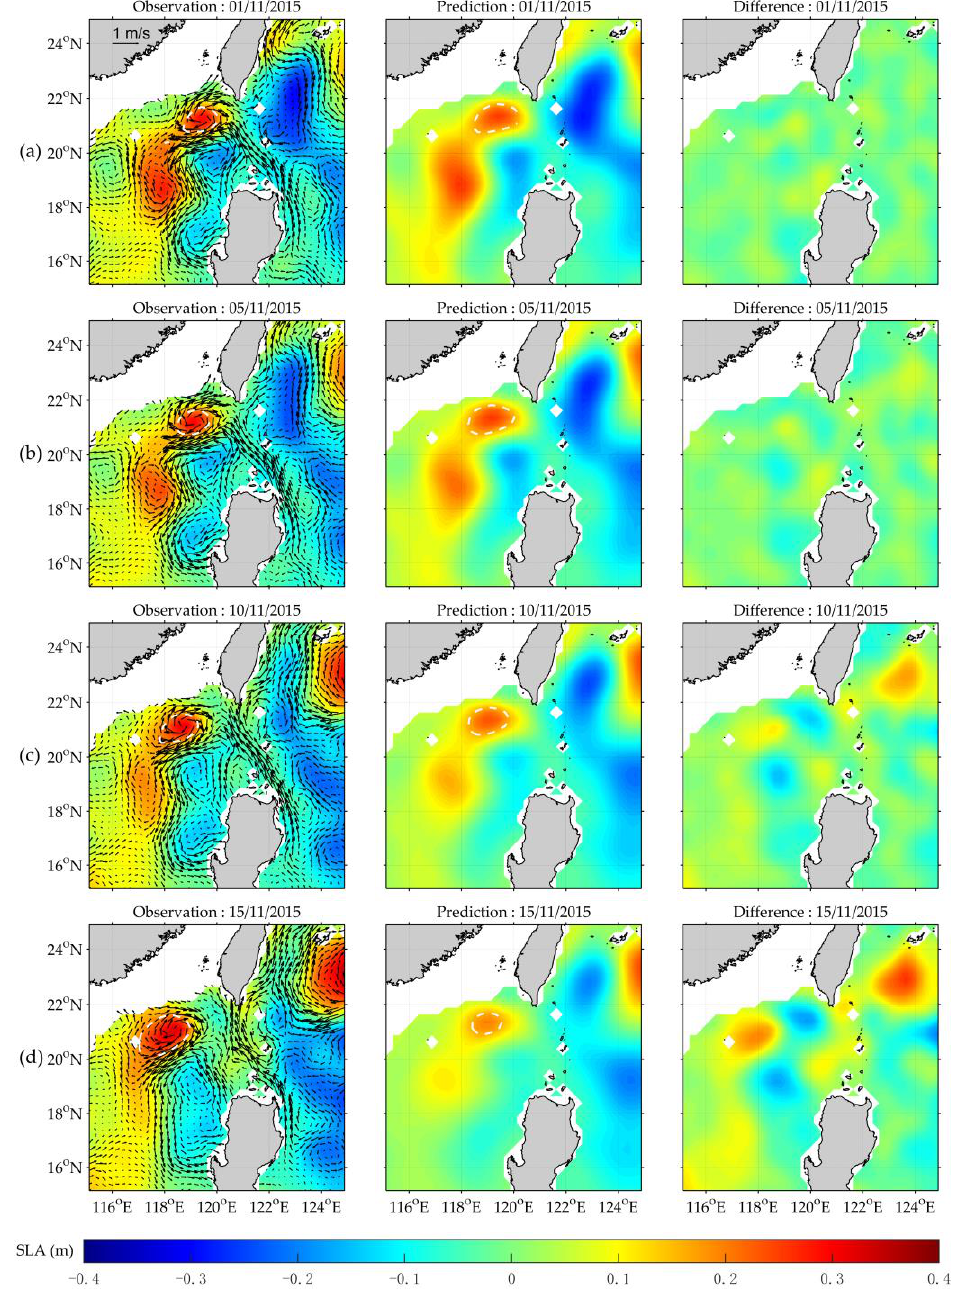
Figure 12. Comparison between observed and predicted SLA at ( a ) day 1, ( b ) day 5, ( c ) day 10, ( d ) day 15. The white dashed line represents the counters of 0.2 m and 0.165 m for observation and prediction, respectively. The red area around the white dashed line are Kuroshio loop current and anticyclone eddies which detach from Kuroshio loop current. The left column shows the results from observation, the middle column shows the results from the prediction, and the right column shows the difference between the observed and predicted SLA . Black vectors are the variation of geostrophic current.